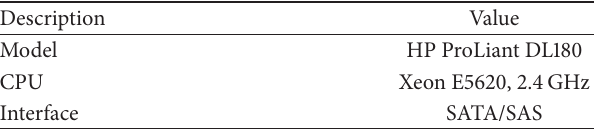
Table 1: The characteristic of the server.